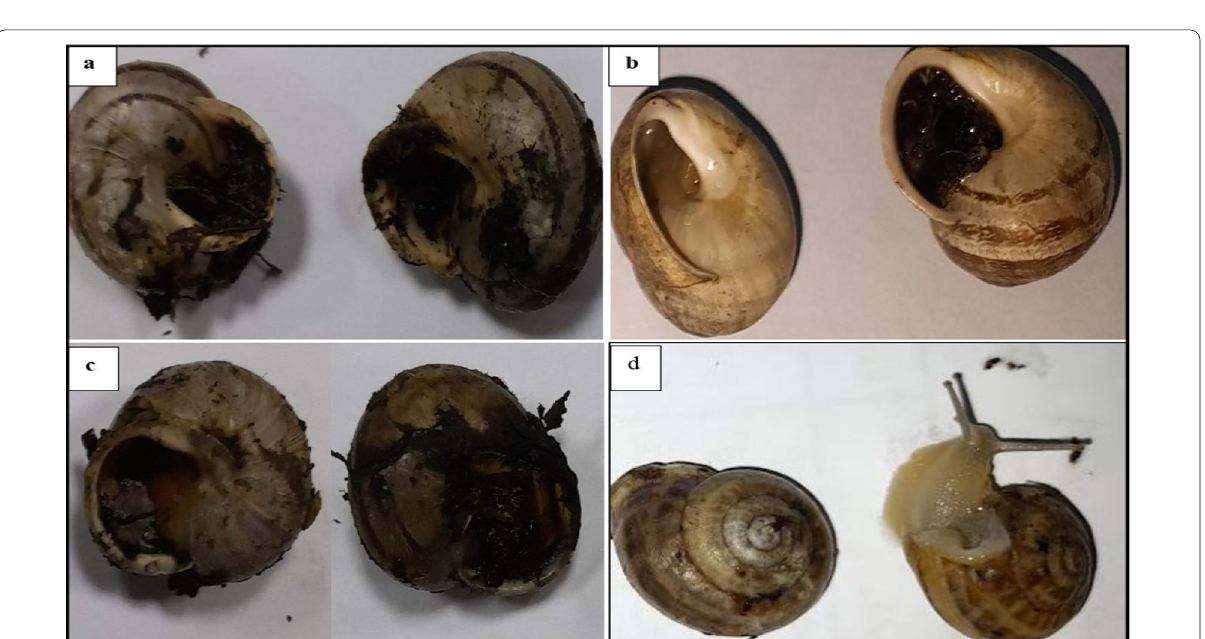
**Means under each concentration sharing the same letter in a column are not significantly different at P < 0.05 ***Means the difference between these data is very significant